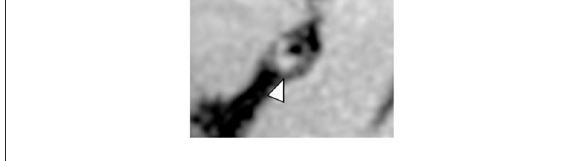
FIGURE4 Intrinsic T1 hyperintense signal of intracranial plaque on precontrast VW-MRI. Orthogonal view of a precontrast VW-MRI of the middle cerebral artery shows intrinsic T1 hyperintense signal (arrowhead) and positive (outward) wall remodeling